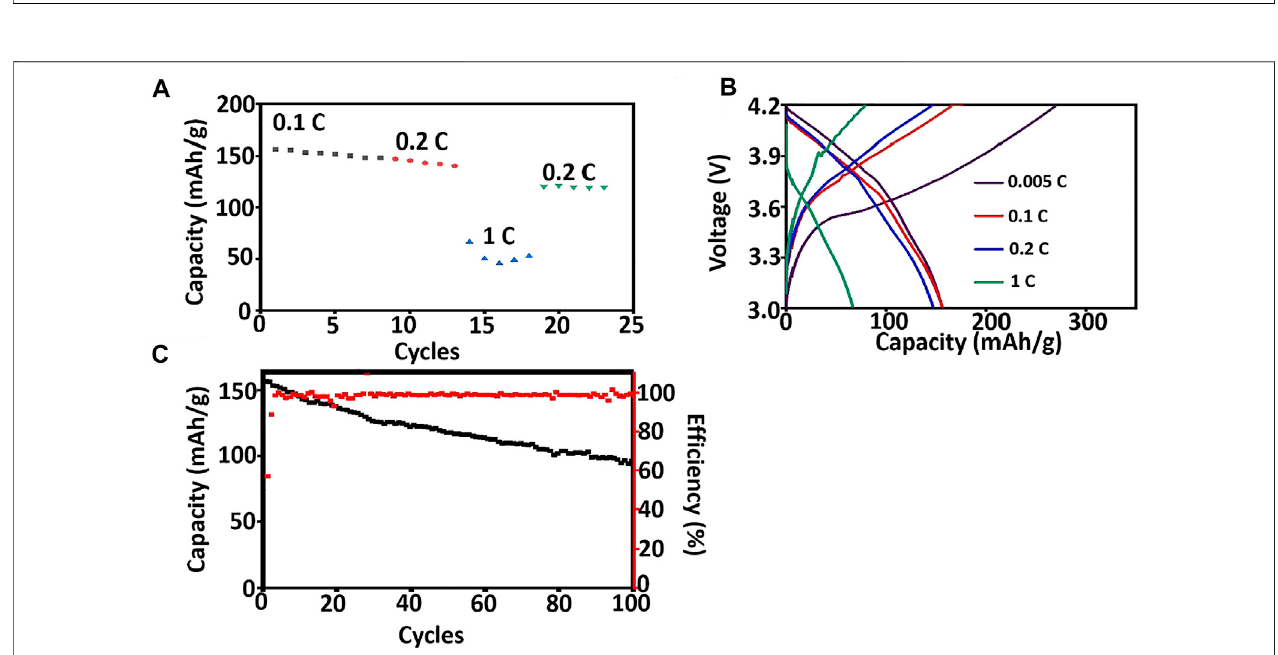
FIGURE 7 | Battery performance of NCM811/ asymmetric organic-inorganic composite solid-state electrolyte/Li at room temperature. (A) discharging capacity at different rates, (B) charging and discharging curves at different rates, (C) long term cycling performance at 0.2 C.